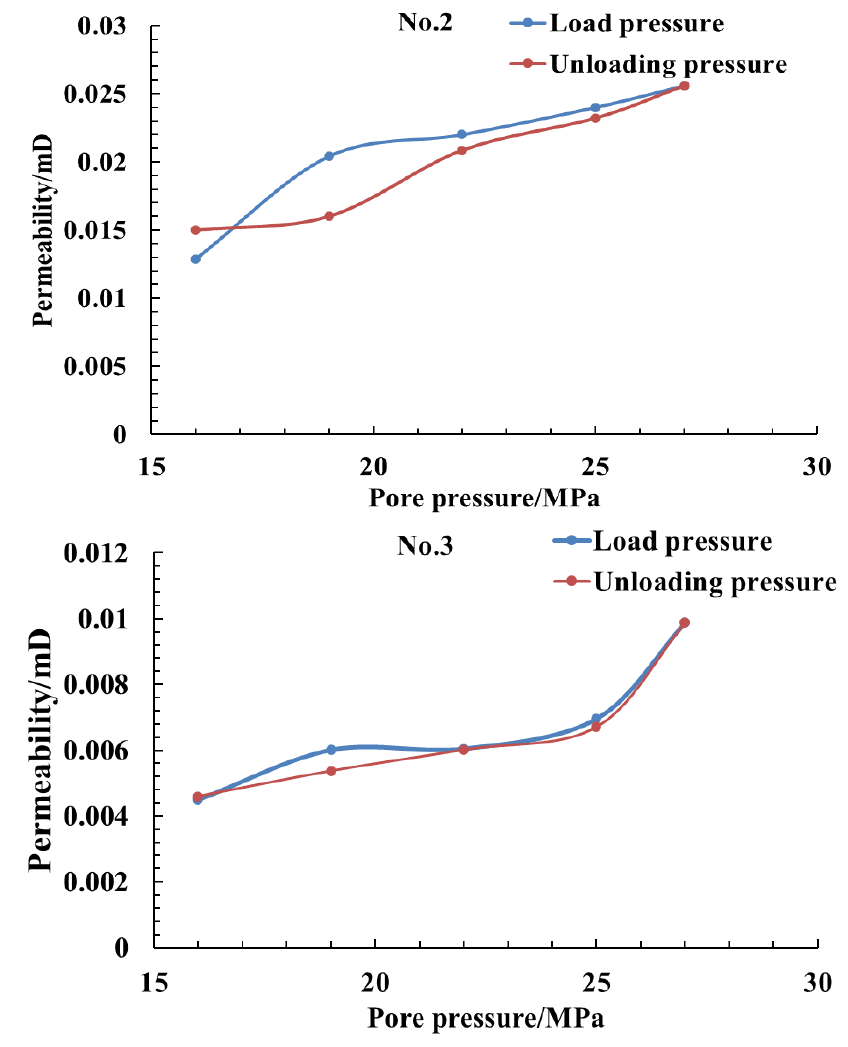
Figure 9. Variation curve of permeability with pore pressure of matrix rock samples.